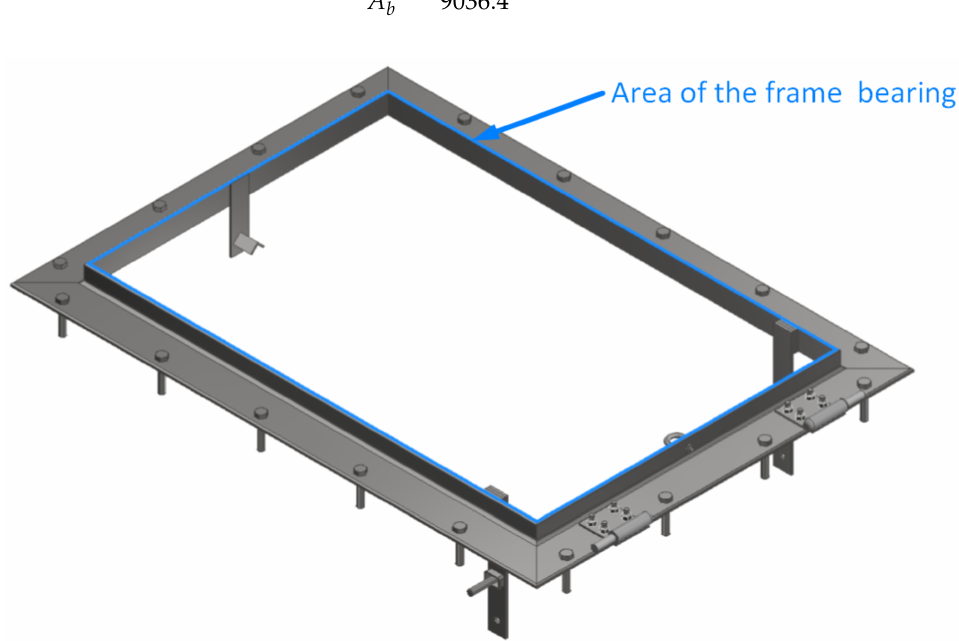
Figure 10. Area of the frame